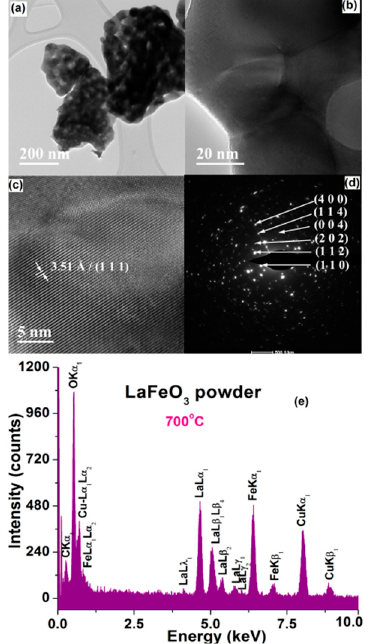
Figure 7. ( a , b ) TEM images of various magnification, ( c ) HRTEM image, ( d ) SAED pattern, and ( e ) EDX spectrum for LaFeO 3 powder calcined at 700 °C.